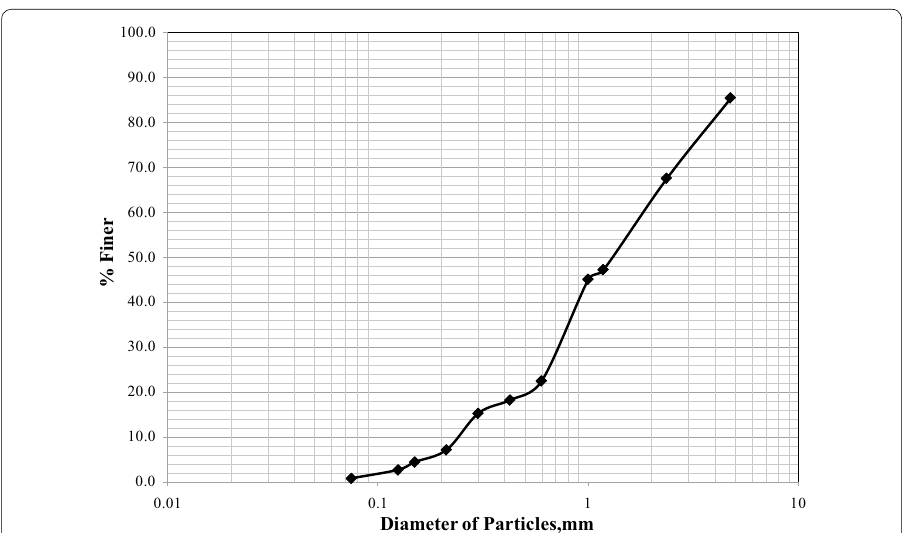
Fig. 4 Particle size distribution curve of the selected solid waste